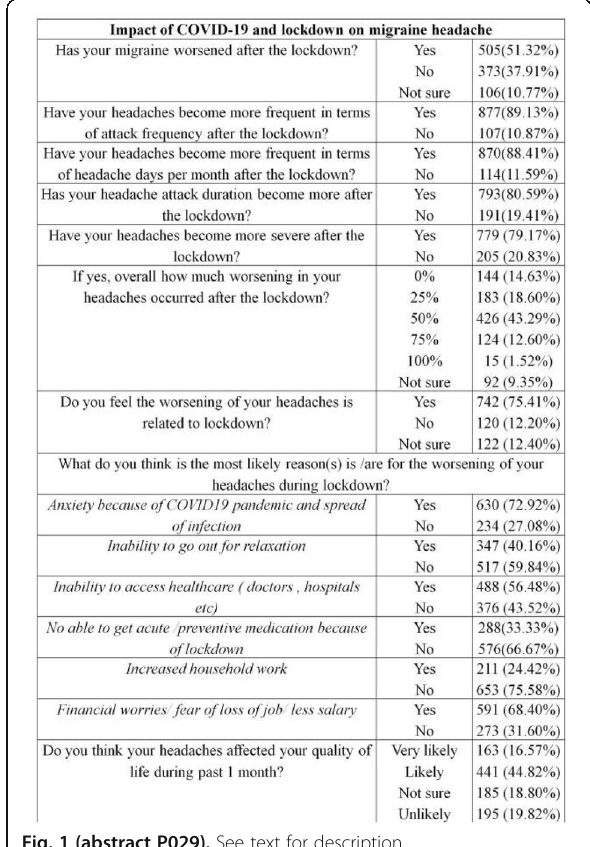
Fig. 1 (abstract P029). See text for